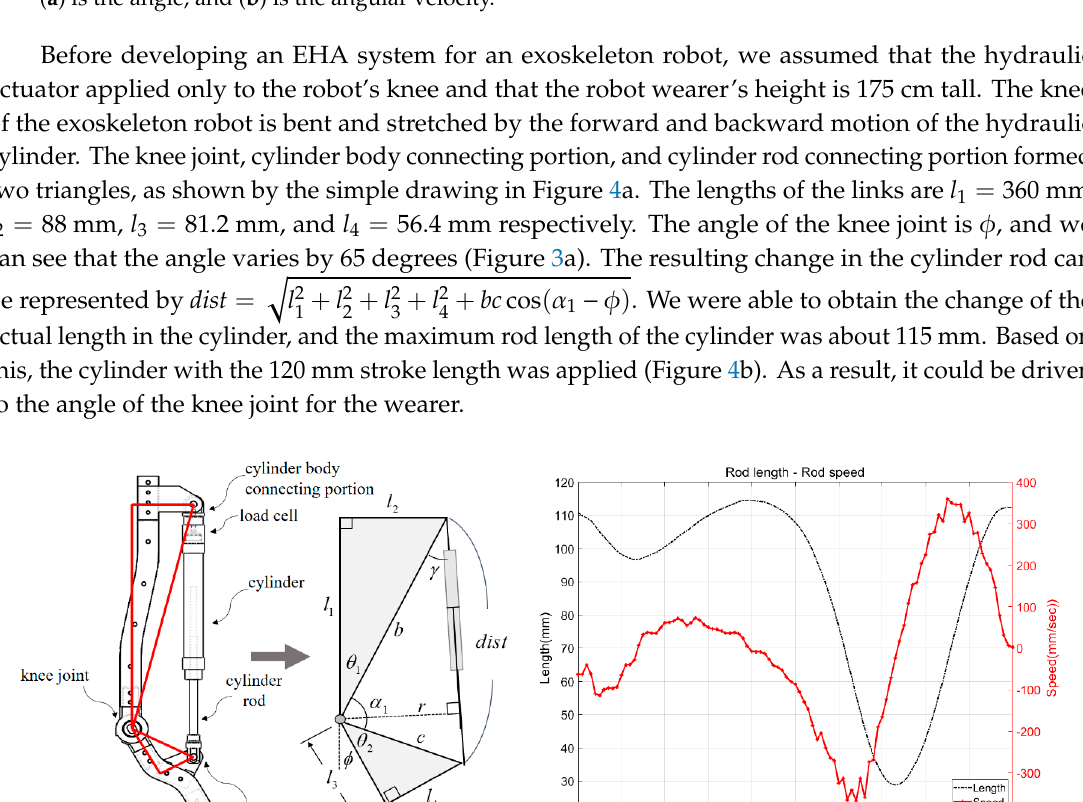
Figure 3. The angle and angular velocity of each joint in the sagittal plane according to the gait cycle: ( a ) is the angle, and ( b ) is the angular velocity.